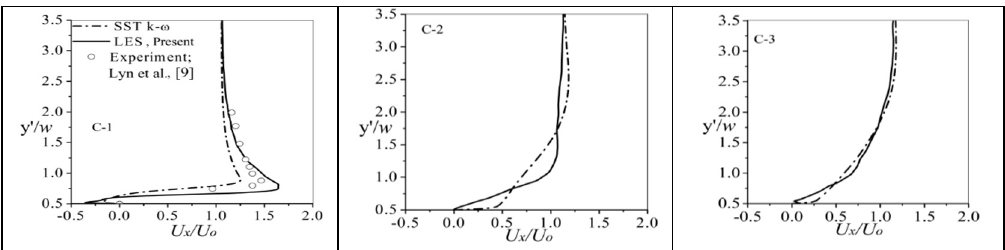
Fig. 12: Time-Averaged Streamwise Velocity (U x /U o ) profiles along Wall Normal Direction of Case-II (a) C-1, at x/w=10.5, and (y’/w=0 at centre) (b) C-2, at x/w=17.5, (c) C-3, at x/w=24.5